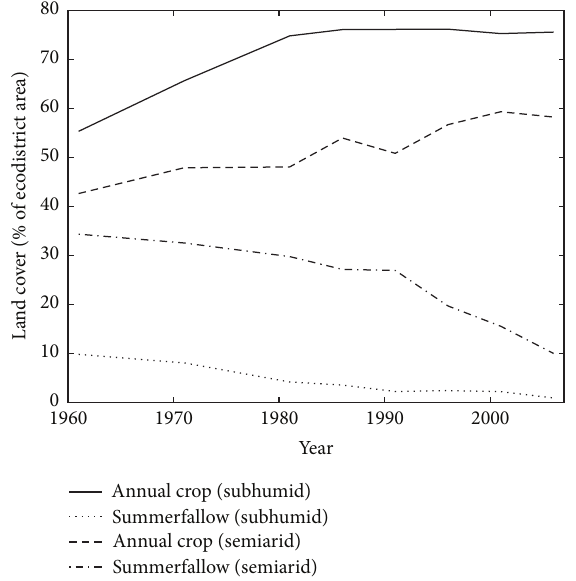
Figure 4: Proportion of area covered by annual crops and summer- fallow in Ecodistrict 849 (subhumid climatic zone) and Ecodistrict 794 (semiarid climatic zone) from 1961 to